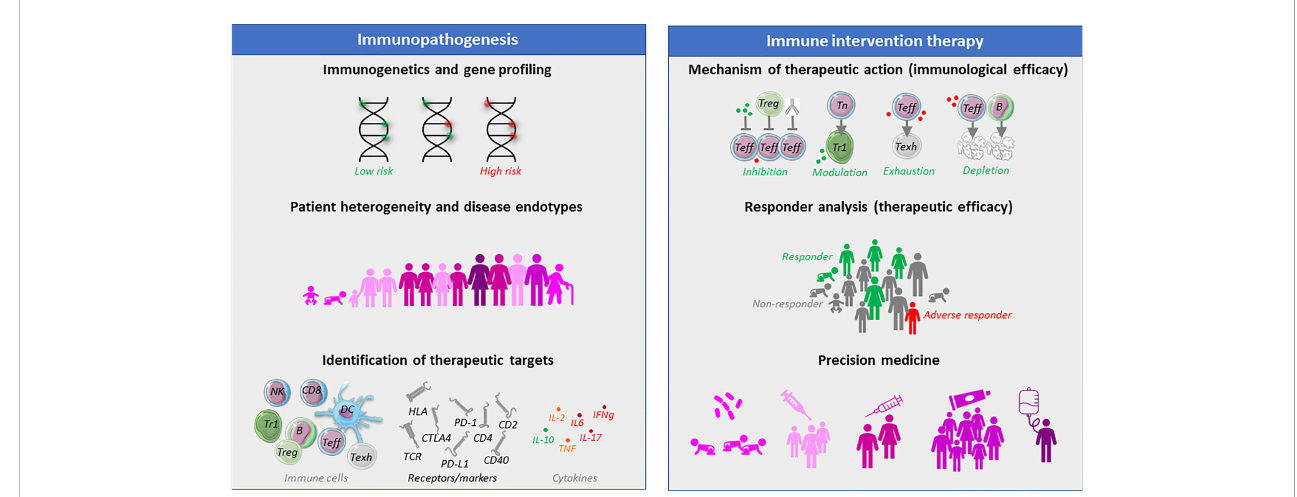
FIGURE 1 The need and bene fi t of immune monitoring of T1D patients before and during therapeutic immune intervention. Different aspects of immune monitoring with regard to de fi ning disease heterogeneity, that may lead to the identi fi cation of targets of therapeutic intervention. Once such immune intervention is explored in clinical trials, immune monitoring can help de fi ne the mechanism of immunological action of an intervention strategy, as well as de fi ne baseline characteristics or immunological correlates that may act as endpoints of clinical therapeutic ef fi cacy. It is believed that immune assays may help determine patient subgroups with particular disease entities (endotypes) with particularly favorable chances of clinical bene fi t (precision medicine), which will avoid subjecting other patients with unlikely clinical bene fi t to a particular therapeutic intervention